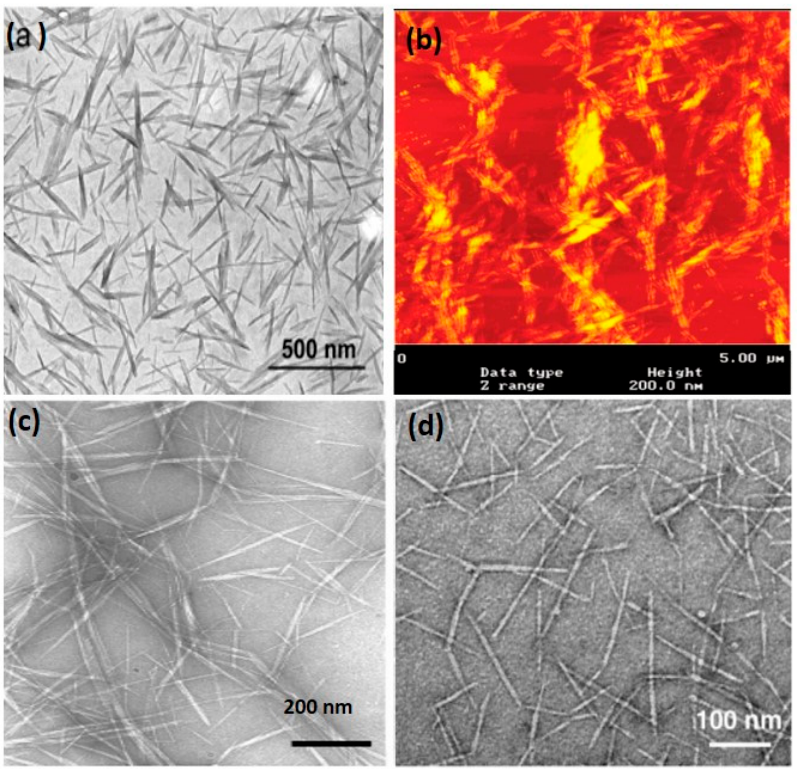
Figure 5. ( a ) TEM [30] and ( b ) AFM [36] images of a dilute suspension of chitin whiskers; ( c ) TEM images of individual chitin whiskers obtained by TEMPO method [28] and ( d ) TEM pictures of individual chitin whiskers from α -chitin partially-deacetylated by fibril surface cationization [54].